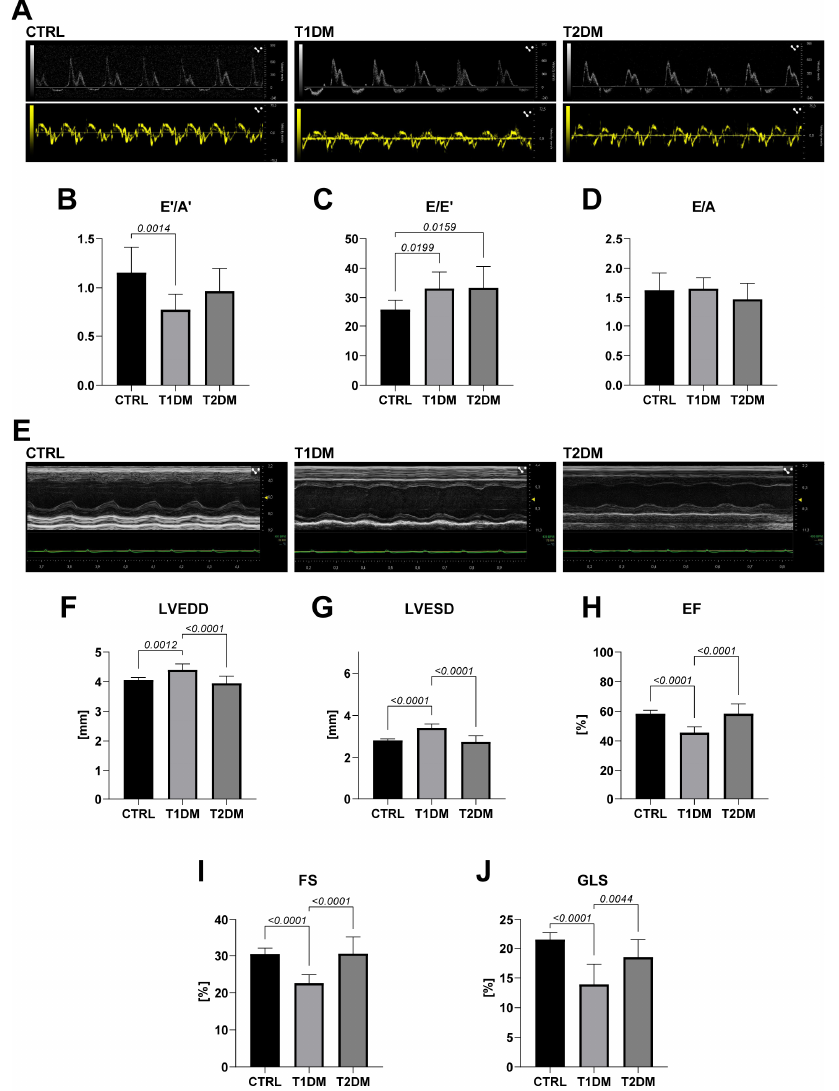
Figure 1. STZ-based T1DM and T2DM mouse models affected left ventricular diastolic and systolic function differently. ( A ) Representative pulsed-wave (PW) Doppler mitral velocity (MV) tracing and PW tissue Doppler imaging (TDI) velocity tracing in T1DM, T2DM and control (CTRL) mice. ( B – D ) Cumulative data of diastolic function: E ′ /A ′ ratio ( B ), E/E ′ ratio ( C ) and E/A ratio ( D ) in T1DM vs. T2DM vs. CTRL mice (CTRL, n = 10; T1DM, n = 11; T2DM, n = 12). B : T1DM vs. CTRL, p = 0.0014. C : T1DM vs. CTRL, p = 0.0199; T2DM vs. CTRL; p = 0.0159 (one-way ANOVA with Tukey multiple comparison test). ( E ) Representative M-mode tracing of long-axis left ventricle in in T1DM, T2DM and CTRL mice. ( F – J ) Cumulative data of cardiac dimensions and systolic function in T1DM and T2DM when compared to control mice 8 weeks after STZ injection (CTRL, n = 10; T1DM, n = 11; T2DM, n = 12). ( F ) LVEDD = left ventricle and diastolic diameter; ( G ) LVESD = left ventricular end-systolic diameter; ( H ) EF = ejection fraction; ( I ) FS = fractional shortening; ( J ) GLS = global longitudinal strain. F : T1DM vs. CTRL, p = 0.0012; T1DM vs. T2DM, p < 0.0001. G : T1DM vs. CTRL, p <0.0001; T2DM vs. CTRL, p < 0.0001. H : T1DM vs. CTRL, p <0.0001; T2DM vs. CTRL, p < 0.0001. I : T1DM vs. CTRL, p < 0.0001. J : T1DM vs. CTRL, p < 0.0001; T1DM vs. T2DM, p = 0.0044 (one-way ANOVA with Tukey multiple comparison test). Data are mean ± SD.